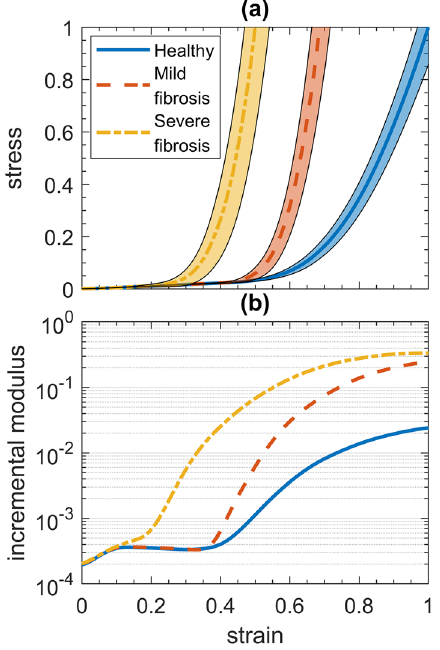
Figure 2. Stress-strain behavior of the model. ( a ) The mean of the stress–strain curves for the three health conditions are marked with shaded regions representing 99% confidence intervals. ( b ) The modulus of the curves in ( a